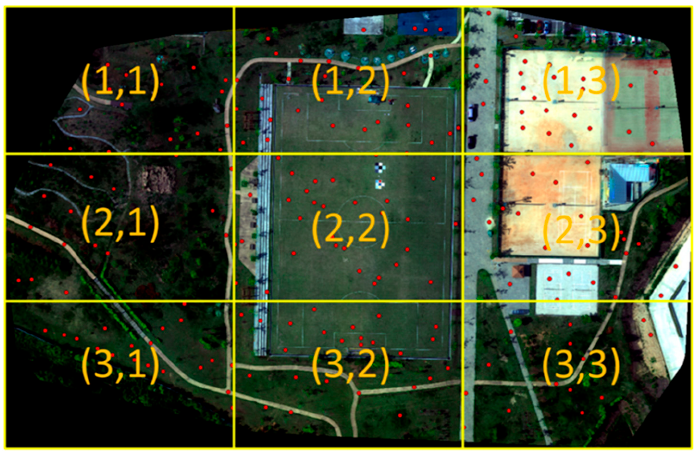
Figure 14. Nine subregions of the mosaicked image (numbers indicate the line and column). Table 3. Exposure values (EVs) in the order of blue (B), green (G), red (R), red-edge (RE), and near-infrared (NIR) for nine subregions.